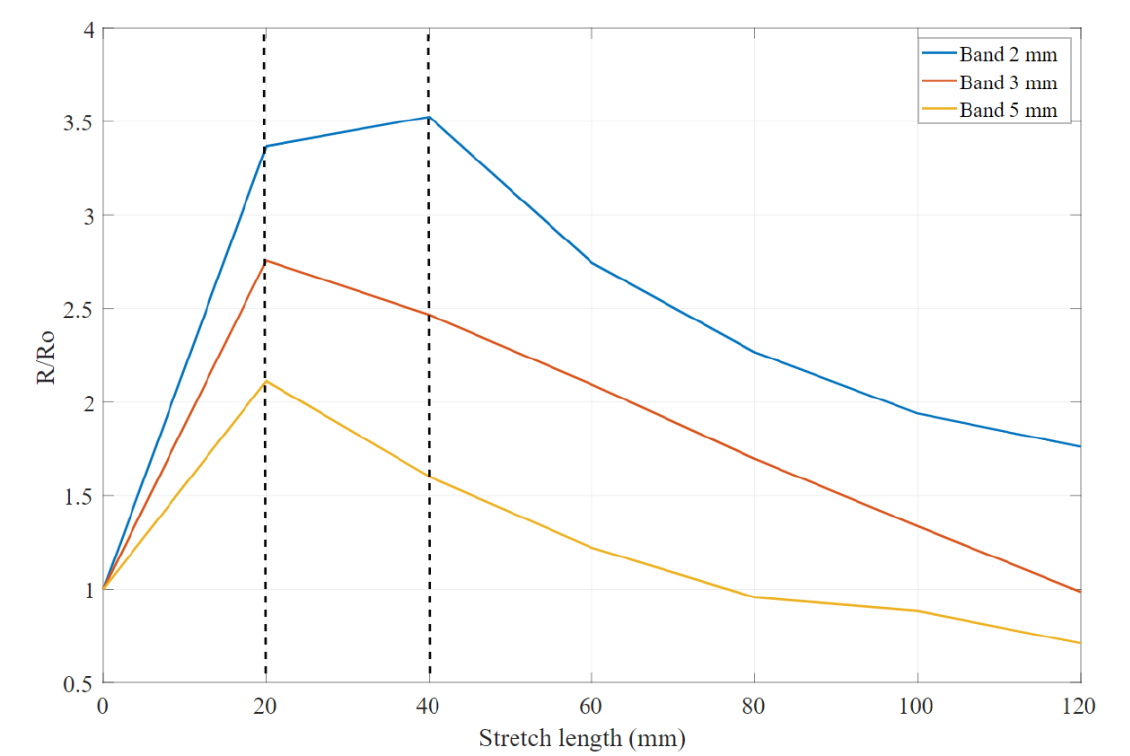
Figure 12. The value of the resistance ratio for each band after stretching up to 120mm.